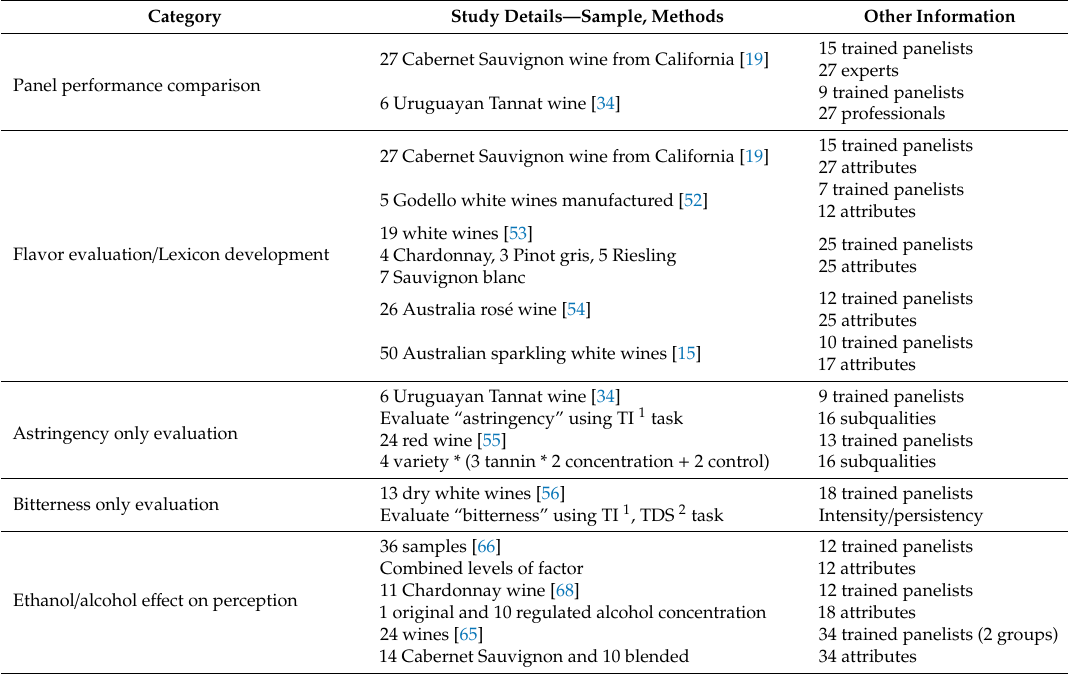
Table 1. Study details and information of descriptive sensory